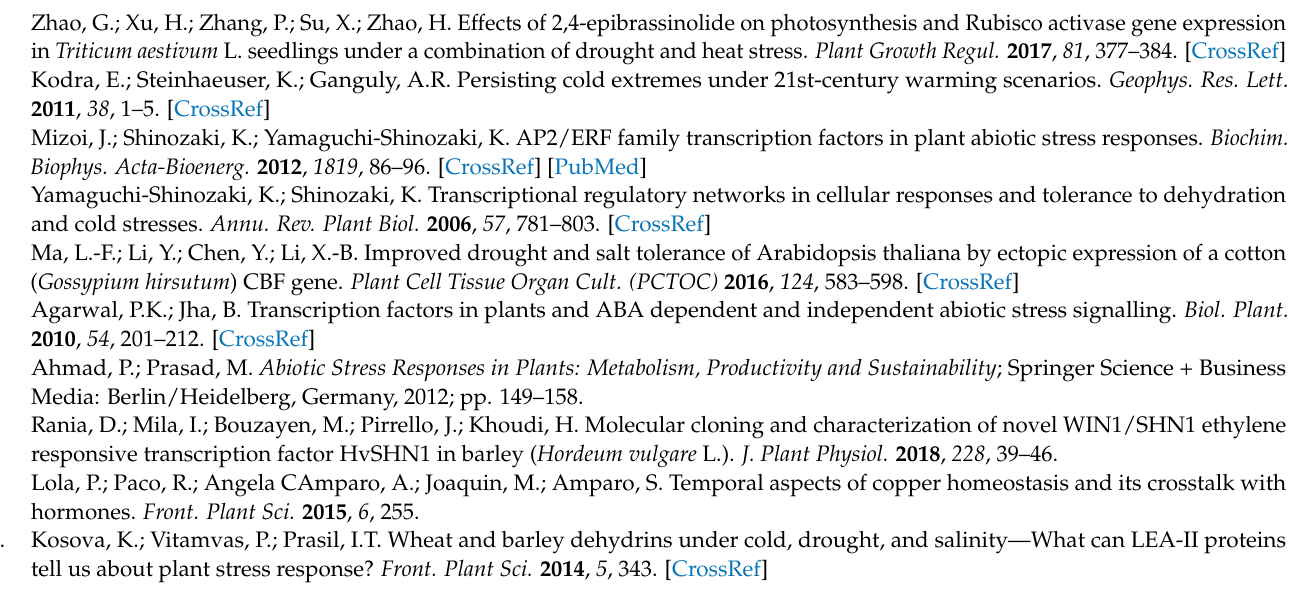
Table S3: Statistics of sequence alignment; Table S4: Summary of the new unigene annotation;